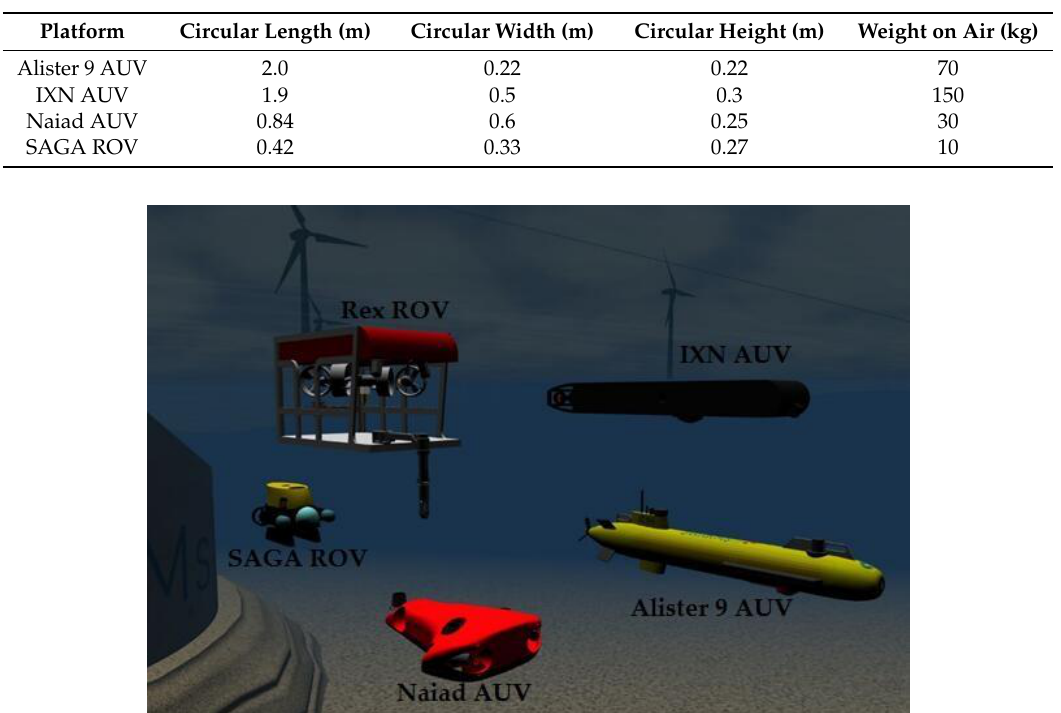
Figure 15. The simulated SWARMs vehicles.